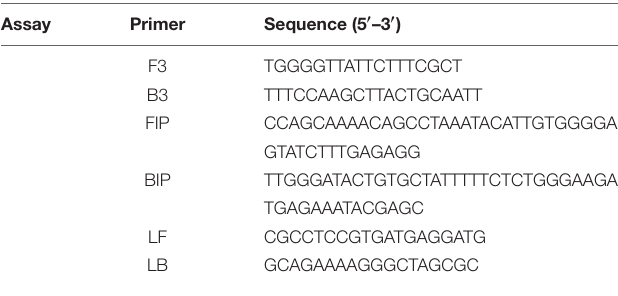
TABLE 2 | LAMP primers used in this